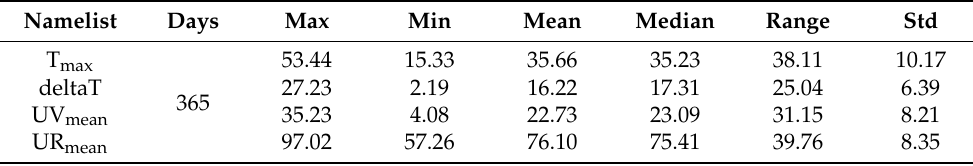
Table 3. Statistical indices calculated for input weather data values, offshore location,